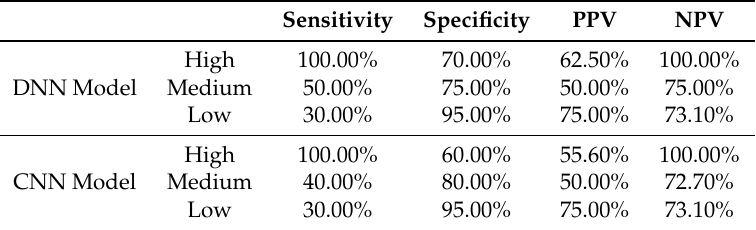
Table 5. Performance measures of the classifiers including positive predictive value (PPV) and negative predictive value